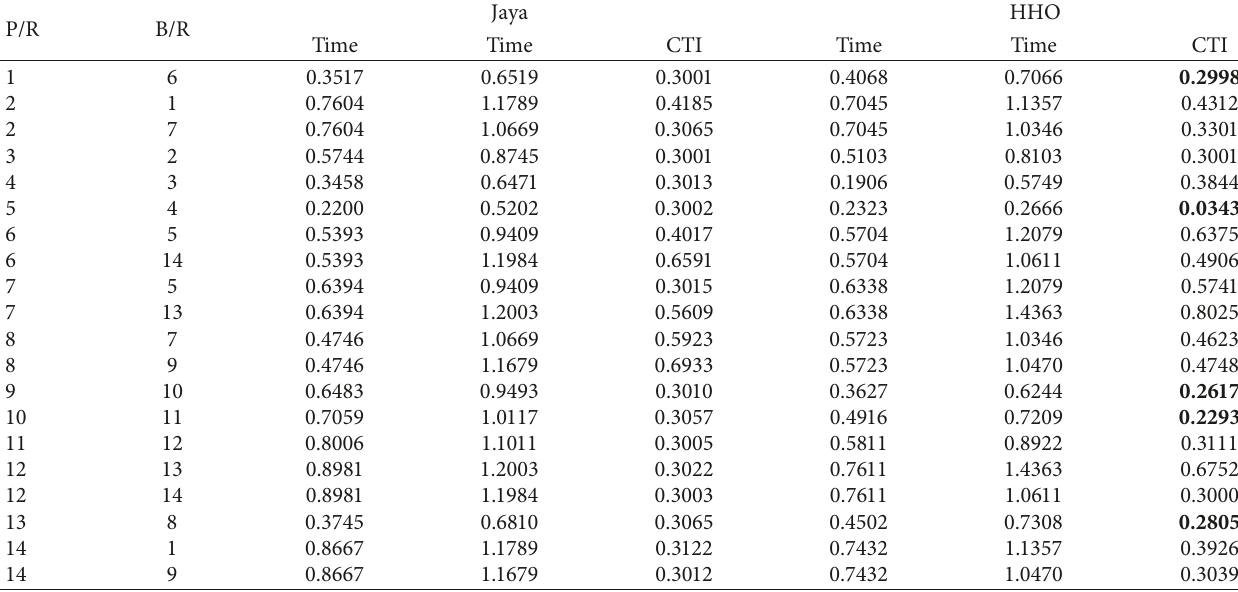
Table 10: Operating time and CTI for the 8-bus system by NLP formulation.